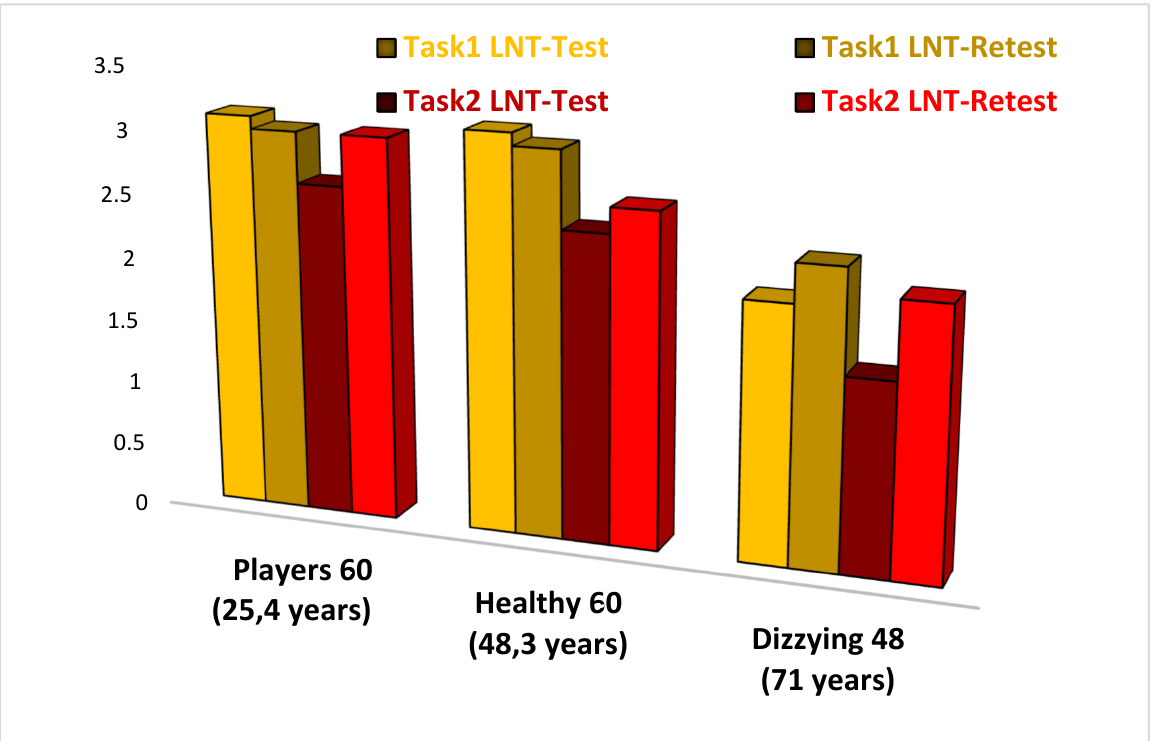
Figure 3. Comparison of NAT 2.0 results in players, healthy non-sporting subjects, and dizzy patients. As it can be seen from the table, there are important differences in the scores of dizzy subjects compared to healthy non-sporting subjects and football players; the latter present Labyrinth Navigation Test scores (LNT), which are better than the other two groups of subjects.